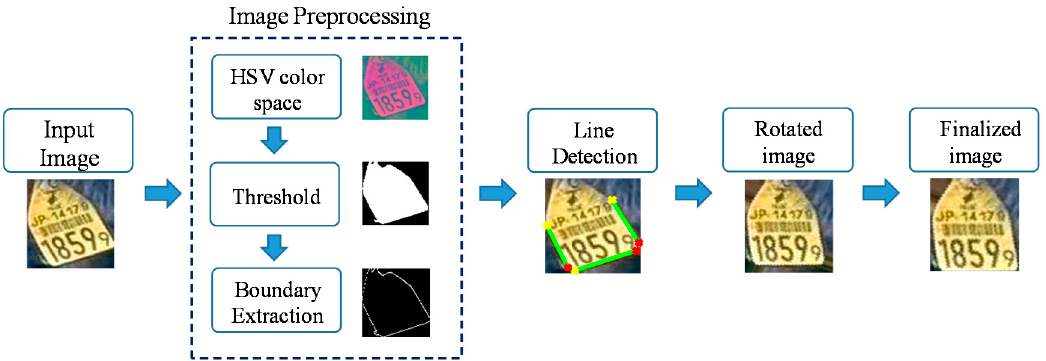
Figure 7. Normalization of ear tag image.